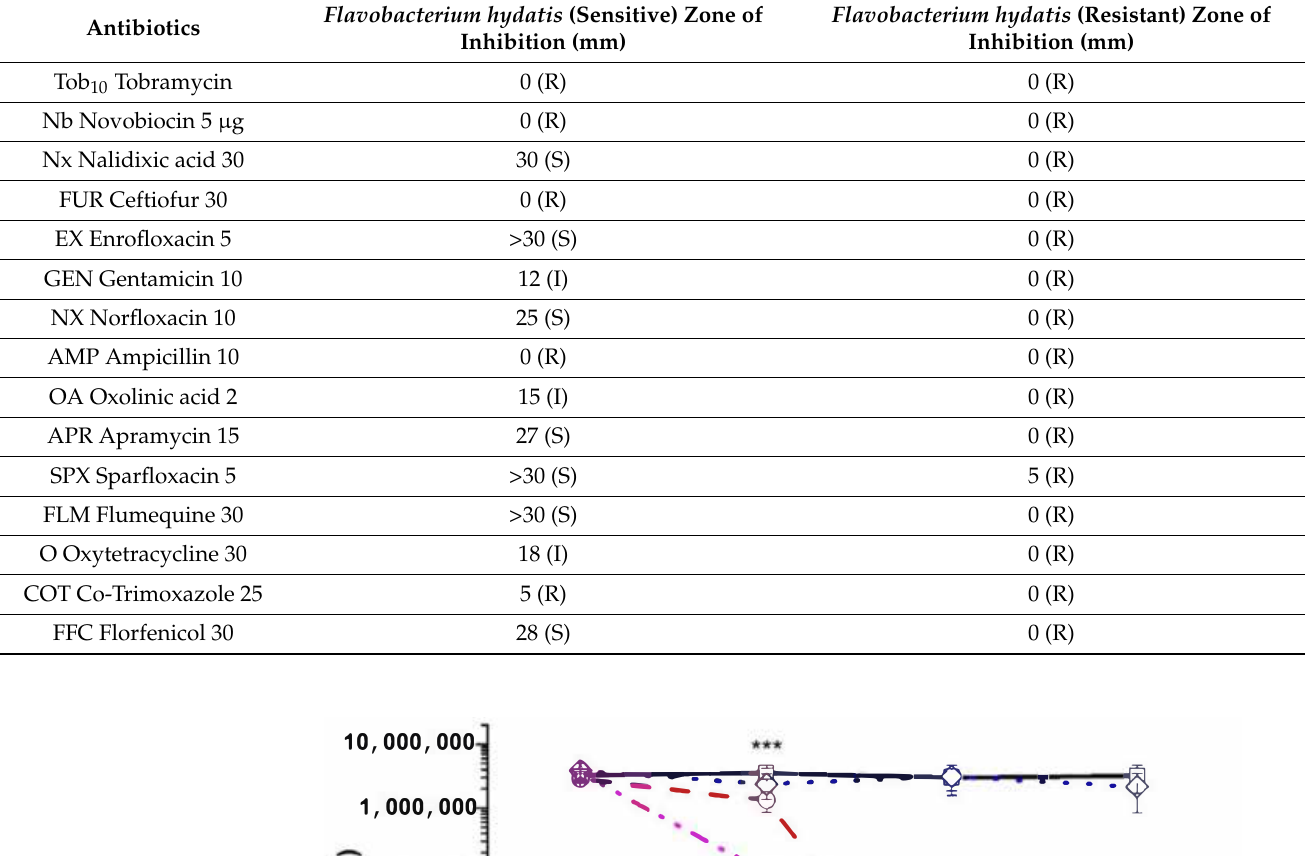
Table 1. Antibiotic-resistant (R) and sensitive (S) strains of Flavobacterium hydatis . Flavobacterium hydatis (Sensitive) Zone of Flavobacterium hydatis (Resistant) Zone of